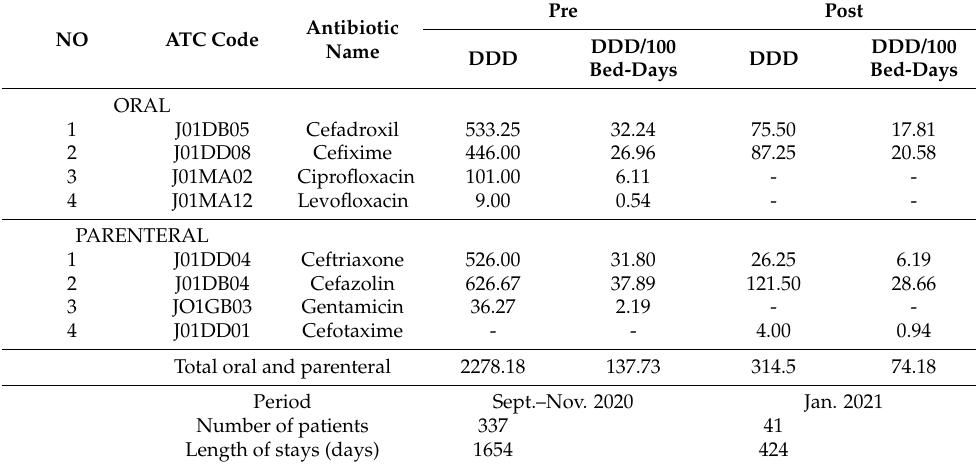
Table 6. Profile of DDD 100 bed-days orthopedic